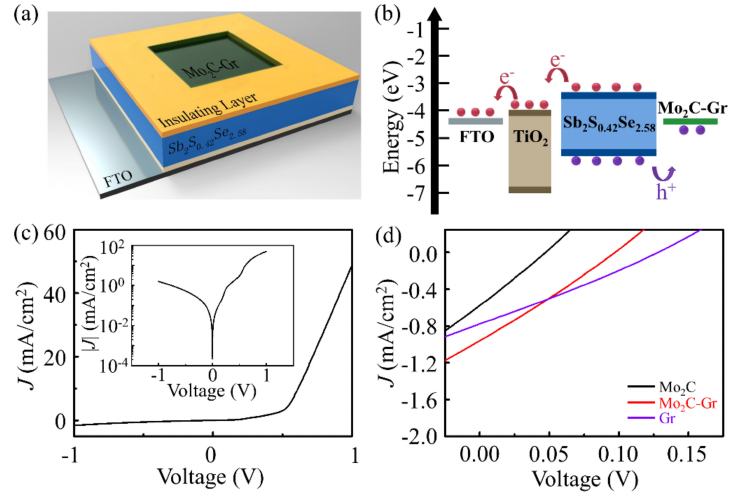
Figure 6. The optoelectronic characteristics of the Mo 2 C—Gr/Sb 2 S 0.42 Se 2.58 /TiO 2 photodetector. ( a ) The schematic diagram of photodetectors. ( b ) The energy band diagram of Mo 2 C—Gr, Sb 2 S 0.42 Se 2.58 , TiO 2 and FTO in the photodetector. ( c ) Dark current-voltage of Mo 2 C—Gr/Sb 2 S 0.42 Se 2.58 /TiO 2 photodetectors. ( d ) Current-voltage curves of Mo 2 C/Sb 2 S 0.42 Se 2.58 /TiO 2 , Mo 2 C—Gr/Sb 2 S 0.42 Se 2.58 /TiO 2 and Gr/Sb 2 S 0.42 Se 2.58 /TiO 2 photodetectors, respectively, under 1.5 G illumination (100 mW/cm − 2